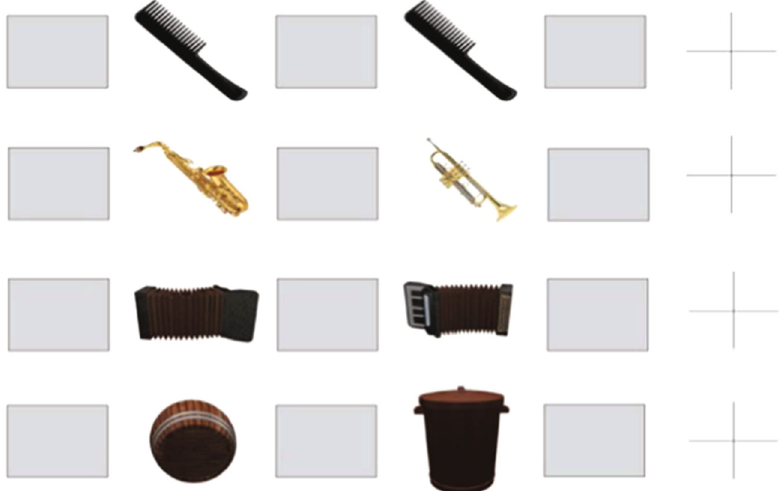
Figure 2: VOMT using conventional and unconventional views of pairs of objects. Line 1: conventional view task condition, correct answer is YES (left button); line 2: conventional view task condition, correct response is NO (right button); line 3: unconventional view task condition, correct response is YES (left button); line 4: unconventional view task condition, correct response is NO (right